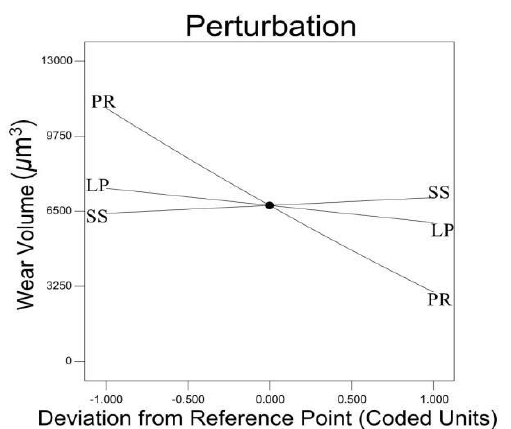
( b ) Figure 12. ( a ) 3D influence of scanning speed and the TiC powder ratio on wear volume. ( b ) Contour line of scanning speed and TiC powder ratio on wear volume.